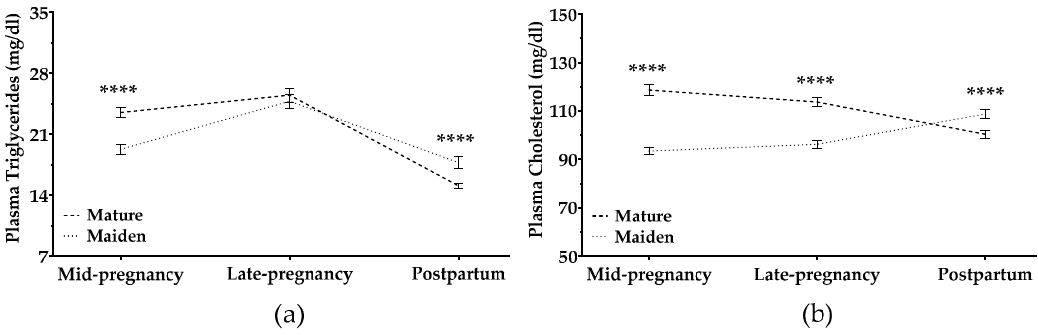
Figure 6. Plasma concentrations (mg/dL) of ( a ) triglycerides and ( b ) cholesterol in mature ewes (dashed line) and maiden ewes (dotted lines). The time × age-group interaction was significant ( p < 0.0001). Asterisks indicate significant differences between age groups at each time point (**** p < 0.0001).